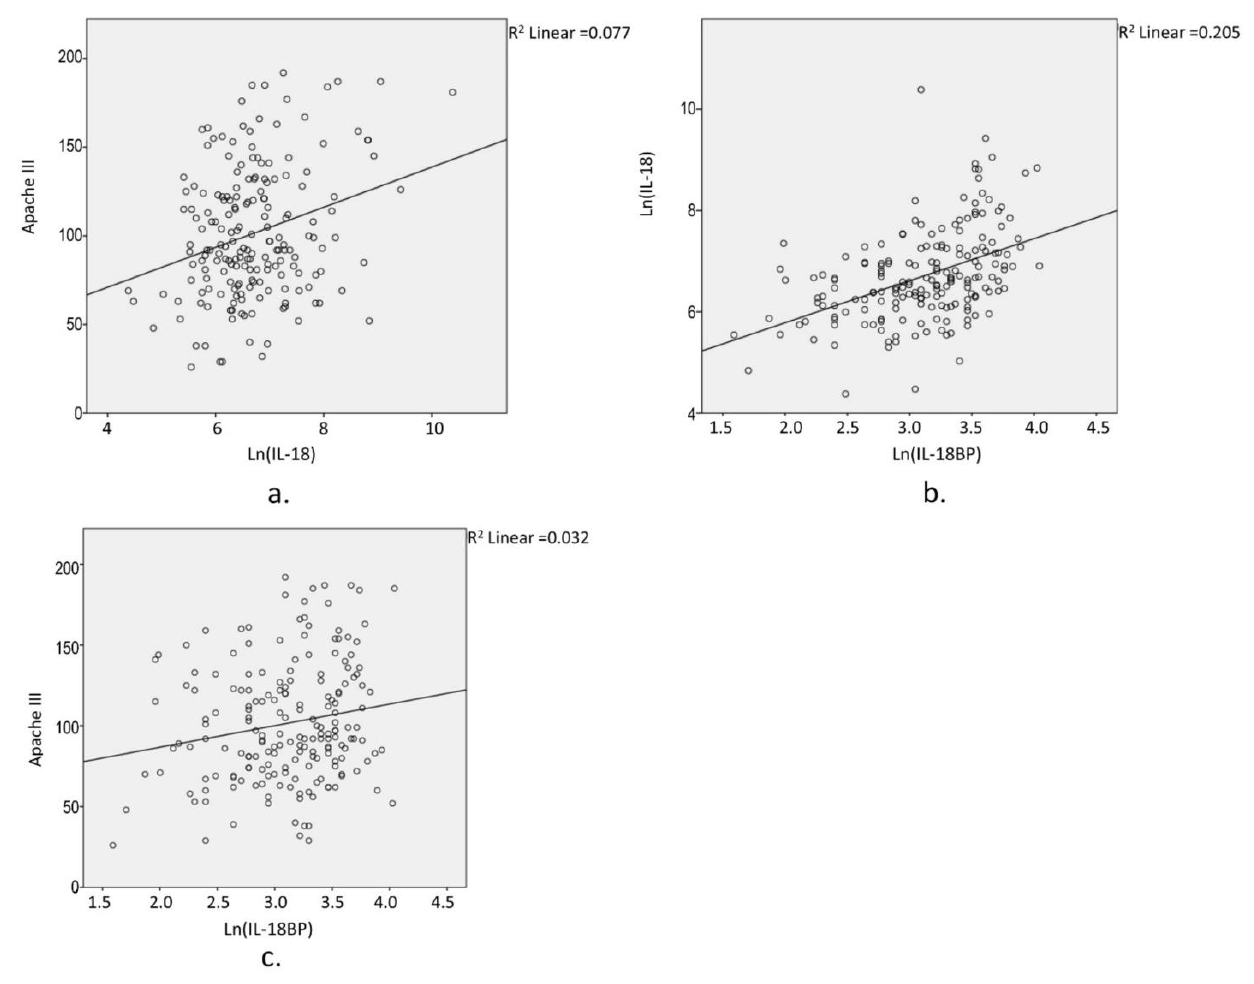
Figure 1. Correlations of Ln (IL-18), Ln (IL-18BP), and Apache III score in bacterial sepsis. The plots presented demonstrate the moderating effects of IL-18BP. To assess the correlation between IL-18 and Apache III score ( a ), the correlation between IL-18BP and IL-18 ( b ), as well as the potential correlation between IL-18BP and Apache III score ( c ), was controlled for in this